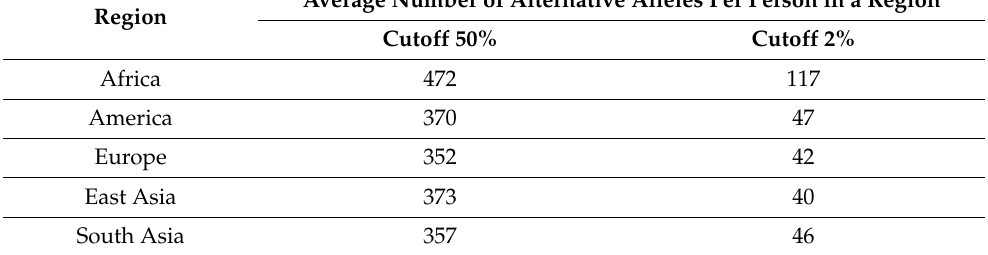
Table 2. Average number of mutations inside UCNE sequences per person in five regions calculated for two cutoffs (2% and 50%) for alternative allele